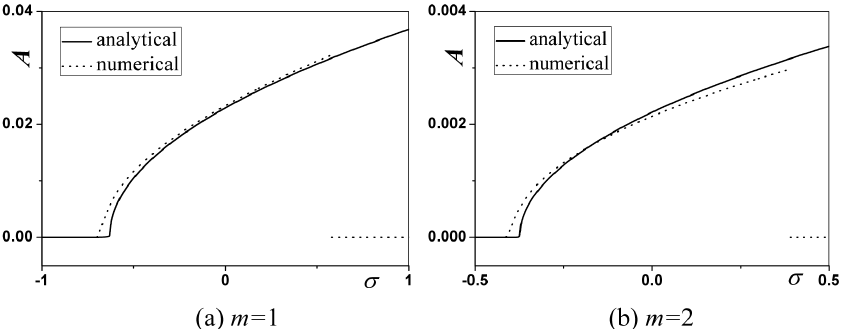
Fig. 16. Comparison of analytical and numerical results: Eq.